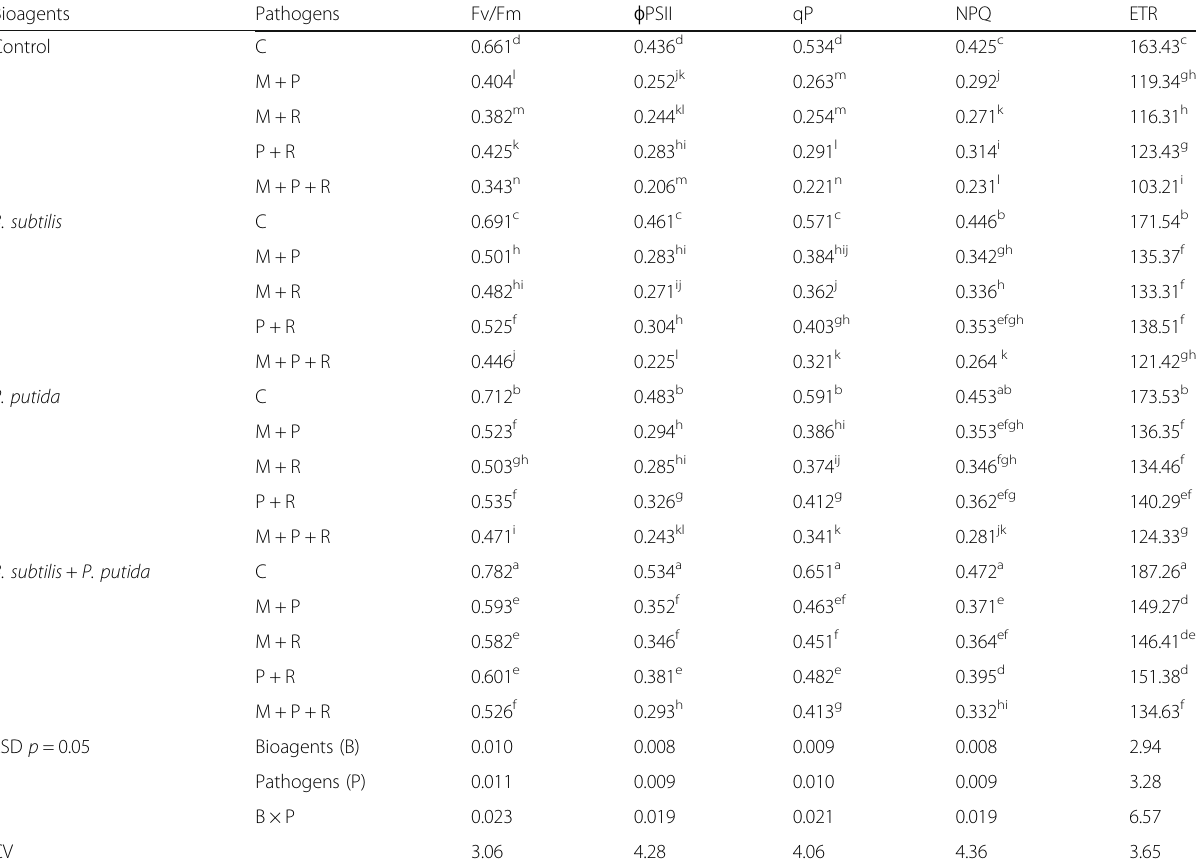
Table 6 Influence of Pseudomonas putida , Bacillus subtilis , and their mixtures on the chlorophyll fluorescence parameters of beetroot infected with two/three pathogens simultaneously in a disease complex incited by Meloidogyne incognita , Pectobacterium betavasculorum , and Rhizoctonia solani